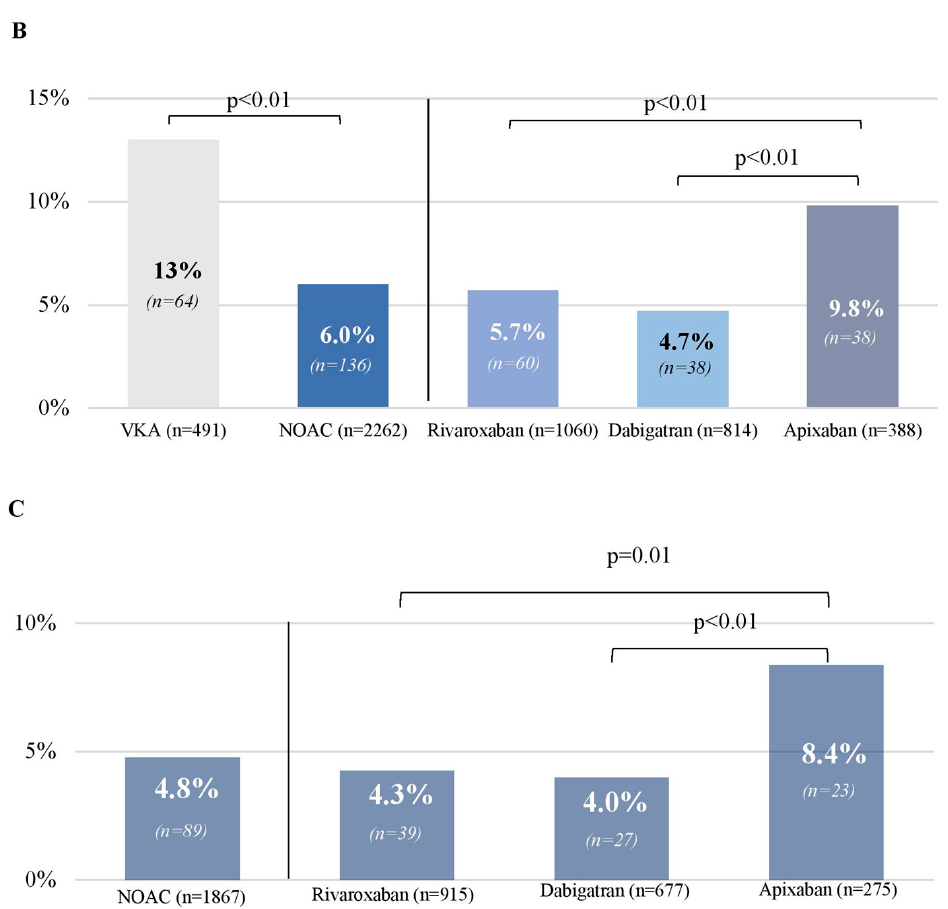
Figure 2. Prevalence of left atrial thrombus in patients with atrial fibrillation/flutter undergoing transesophageal echocardiography before cardioversion or ablation. ( A ): Overall ( n = 3109). ( B ): In patients on chronic oral anticoagulation ( n = 2753). ( C ): In patients on standard doses of non-vitamin K oral anticoagulants (NOAC) ( n = 1867). Legend: Only p -values of 0.05 or lower were shown for group comparisons. Abbreviations: NOAC, non-voitamin K oral anticoagulant; OAC, oral anicoagulation; VKA, vitamin K antagonist.